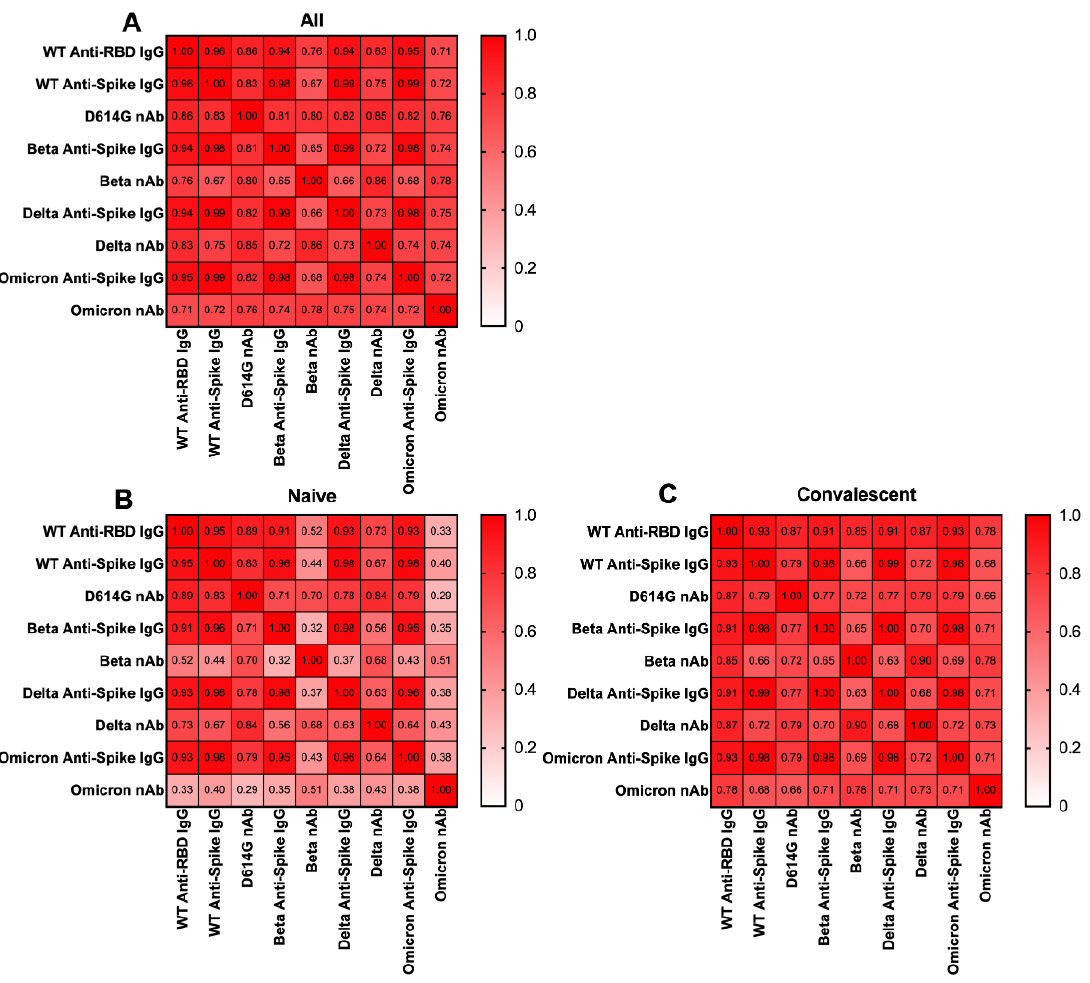
Figure 2. Heatmaps showing the correlations among anti-spike IgG assays, anti-RBD IgG assays and Pseudovirus Neutralization (nAb) assays against WT, Beta, Delta and Omicron. Anti-spike IgG, anti-RBD IgG and nAb data for all individuals ( n = 163) ( A ), naive individuals ( n = 87) ( B ) and convalescent individuals ( n = 76) ( C ) from 3 timepoints were used to perform Spearman’s Correlation to assess correlation between anti-apike IgG levels and nAb titers.